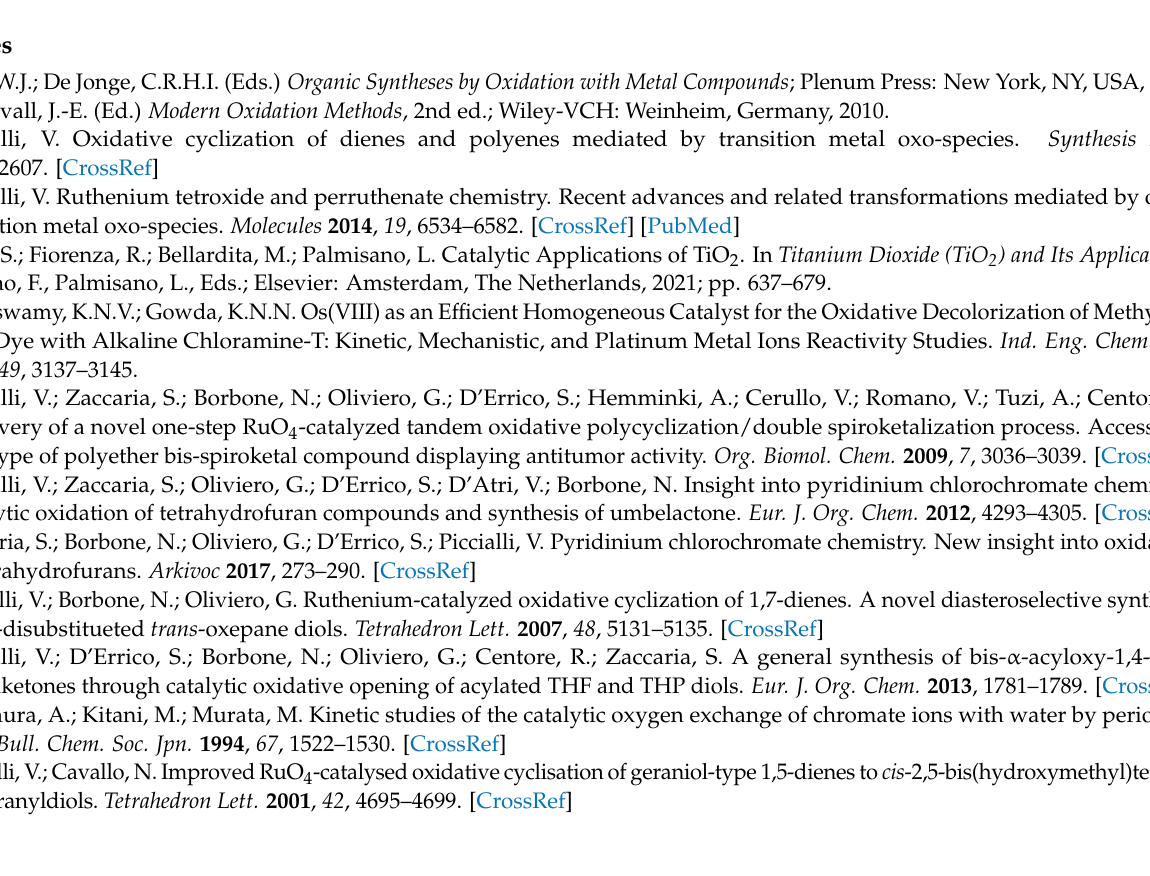
Figure S2: 13 C-NMR spectrum of 5 , Figure S3: FTIR spectrum of 5 , Figure S4: HRESIMS of 5